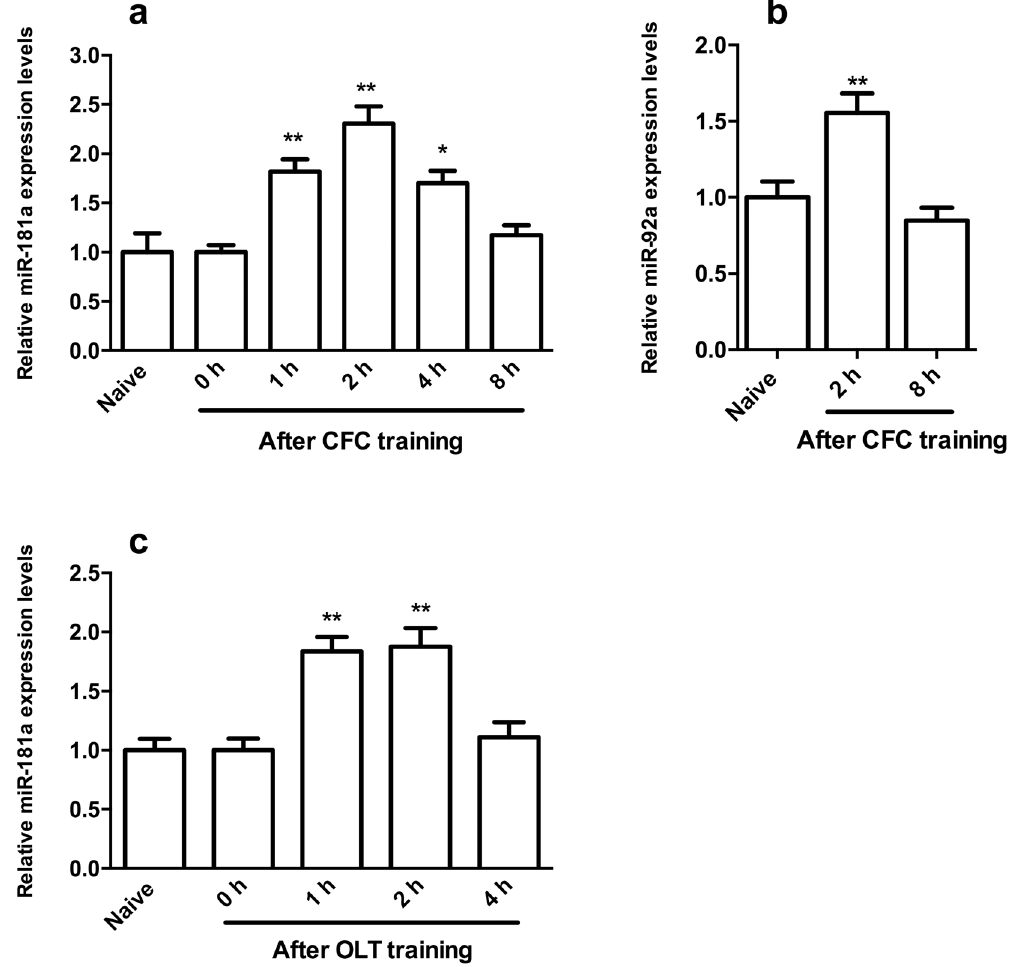
Figure 1. The expression of miR-181a was transiently upregulated in the DH after CFC and OLT training. ( a ) qPCR analysis showing the relative levels of miR-181a expression in the mouse DH at different time points after CFC training. * p < 0.05, ** p < 0.01, compared with the naïve group. ( b ) Relative levels of miR-92a expression in the mouse DH 2 h or 8 h after CFC training. ** p < 0.01, compared with the naïve group. ( c ) Relative levels of miR-181a expression in the mouse DH at different time points after OLT training. ** p < 0.01, compared with the 0 h group. n = 6 per group. All values are presented as means ±